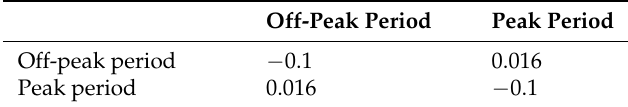
Table 2. DRP self and cross-price elasticities of demand